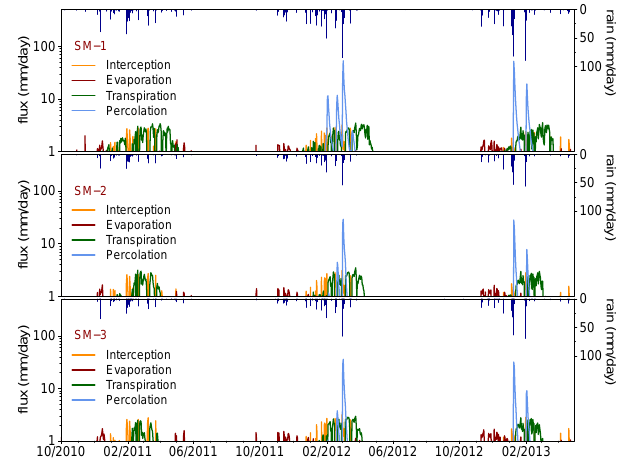
Figure 8. Simulated daily water fluxes at the single soil moisture plots for the simulation period